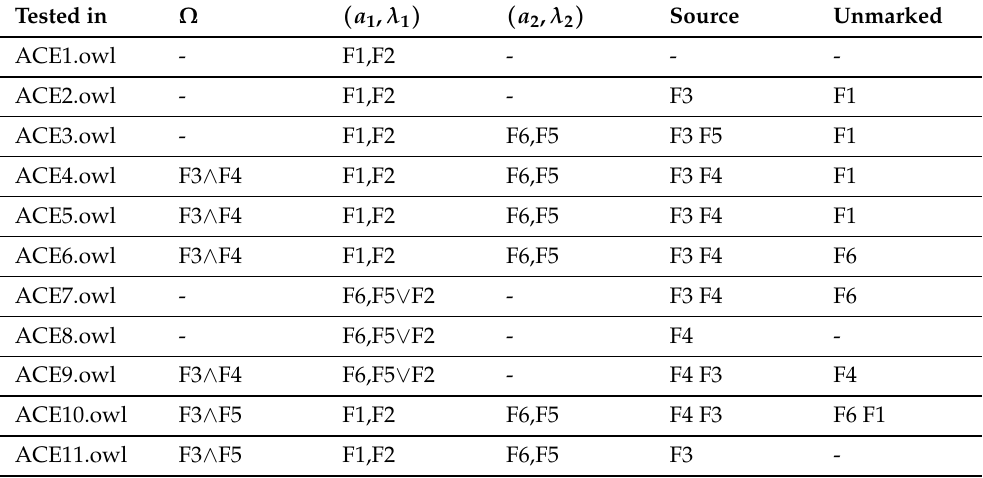
Table 1. Summary of RACE